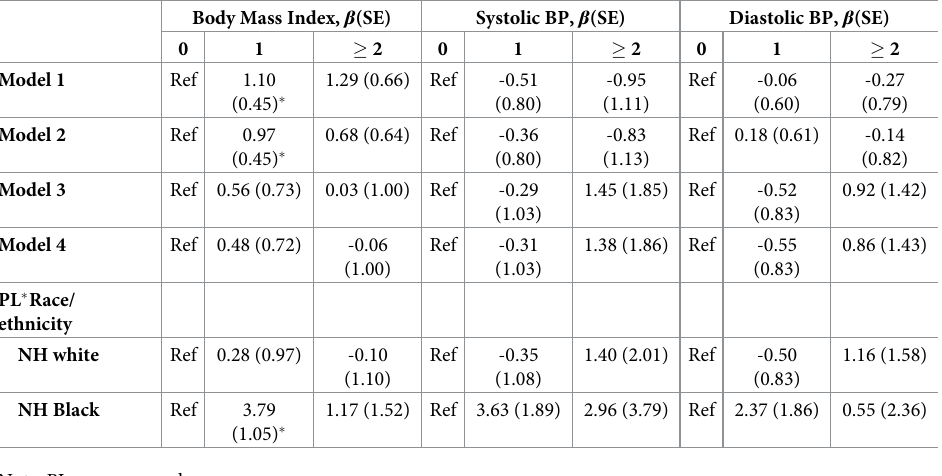
Table 2. Associations between pregnancy loss, BMI, and blood pressure.